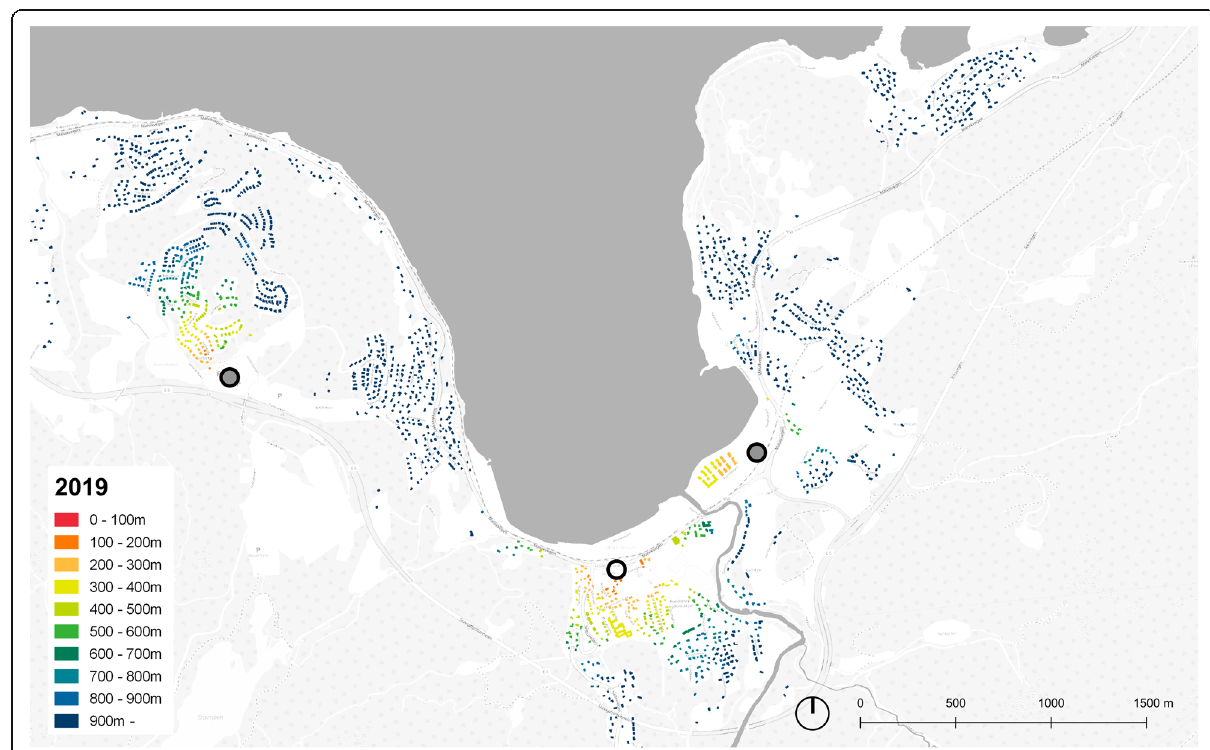
Fig. 4 Distance to grocery stores, Hommelvik, 2019. Stores marked with circles, filled circles representing stores opened since